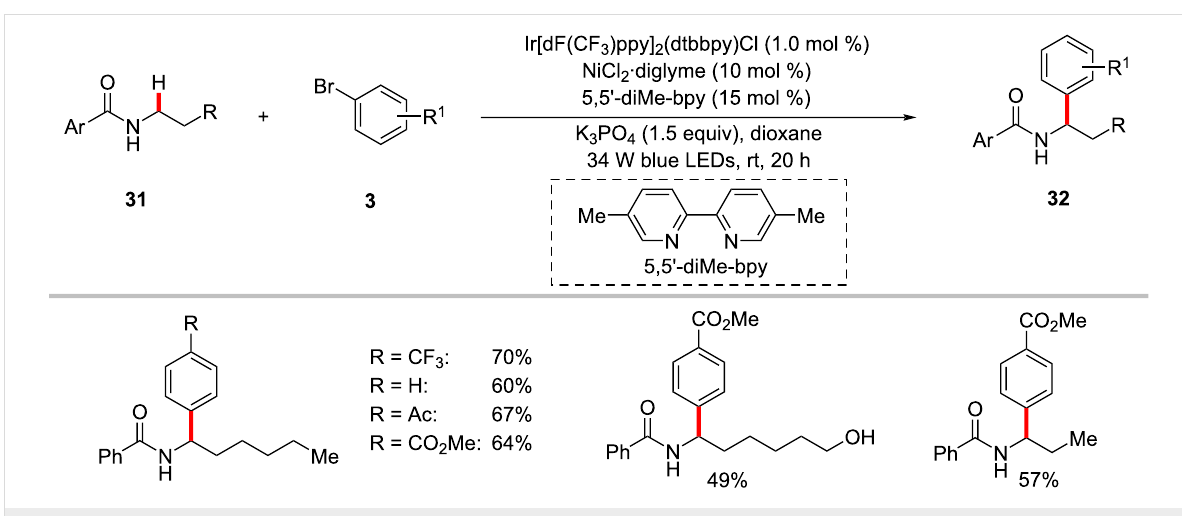
Scheme 18: Photoredox nickel-catalyzed α -(sp 3 ) ‒ H arylation of secondary benzamides with aryl